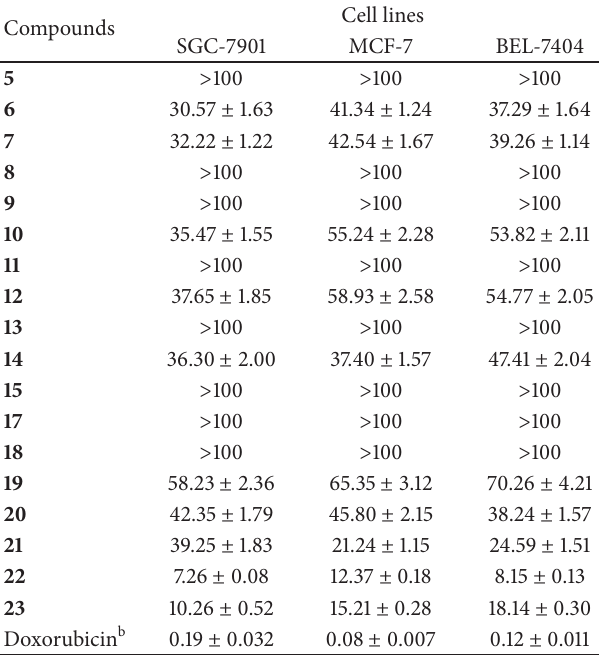
Table 1: Cytotoxicity of compounds 5 – 19 against three human tumor cell lines (IC 50 , 𝜇 M) a